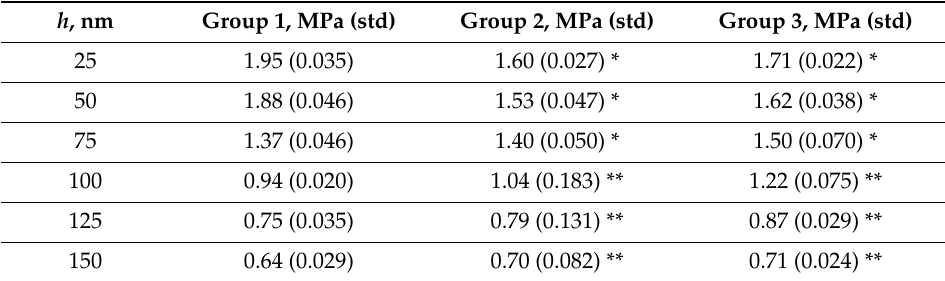
Table 1. The Young’s modulus from the indentation depth.